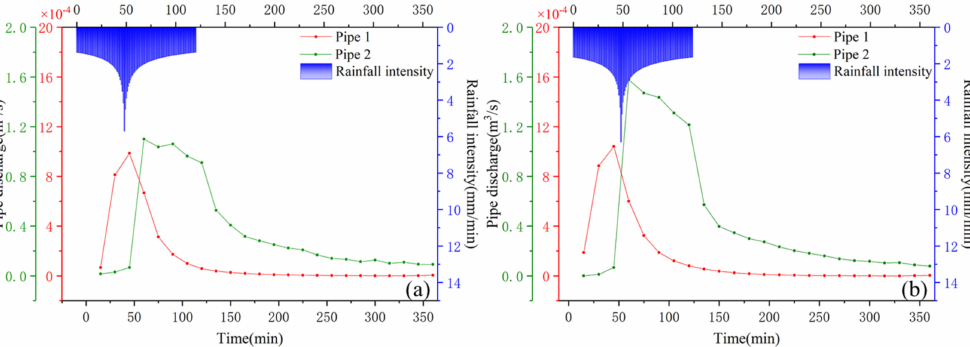
Figure 7. The typical pipe inflow process under different return periods. ( a ) 50-year return period; ( b ) 100-year return